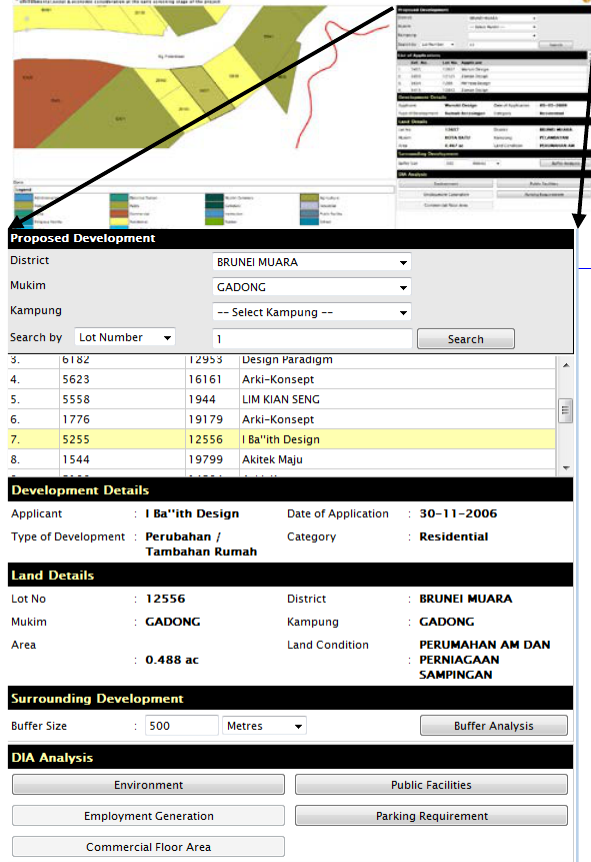
Figure 5: e-DIA analysis page showing detail information of selected planning application and analysis